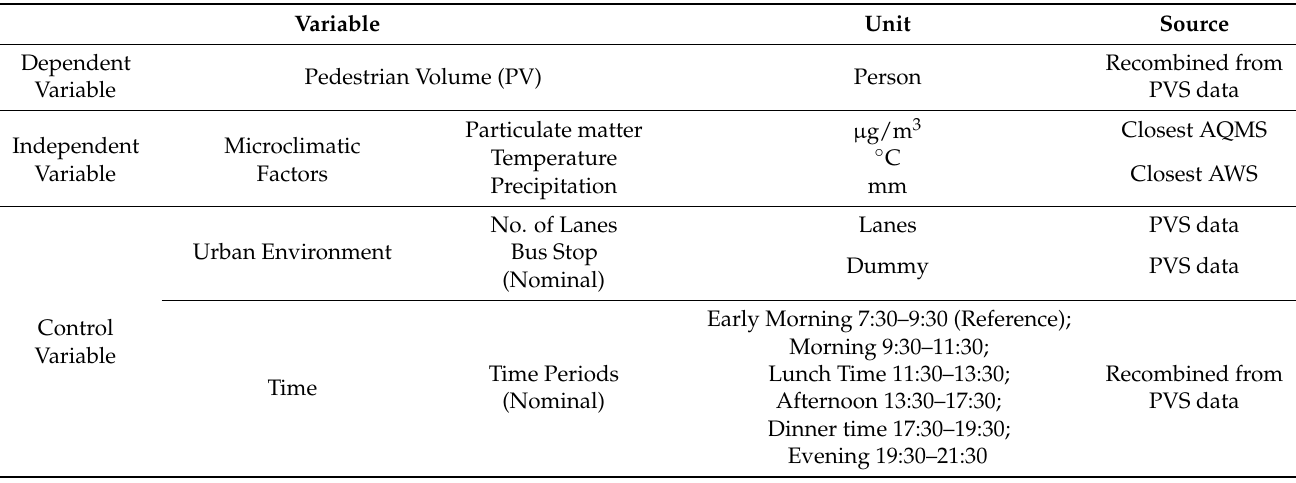
Table 5. List of variables included in this